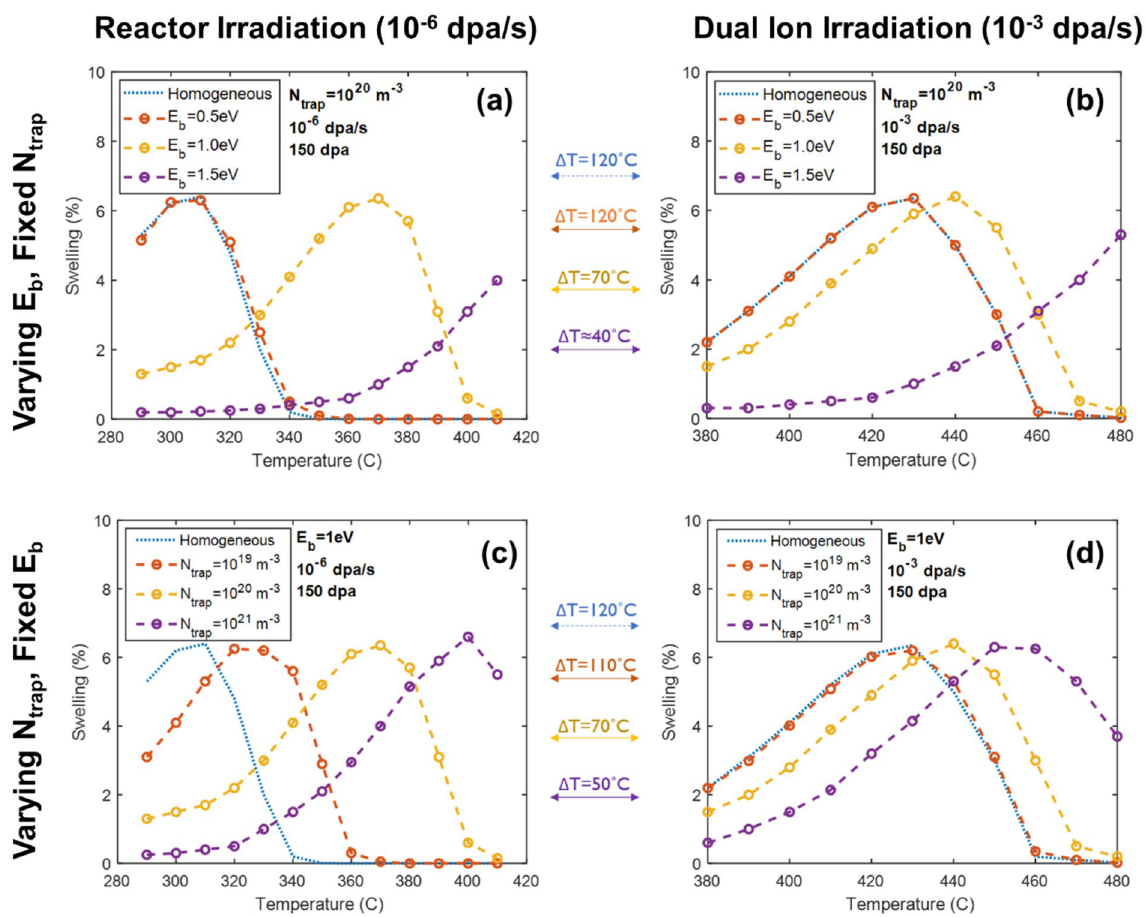
Figure 4. Swelling at 150 dpa as a function of temperature at ( a ) reactor and ( b ) ion irradiation dose rates, generated by a cavity-biased CD simulation for a range of helium-trap binding energies, and the same ( c ) reactor and ( d ) ion irradiation dose rates for a range of trap densities. Even though an increase in either helium binding energy or trap density increases the temperature range over which swelling occurs, the effect is non-linear with increasing damage rate and results in the reduction in the ΔT between reactor and ion